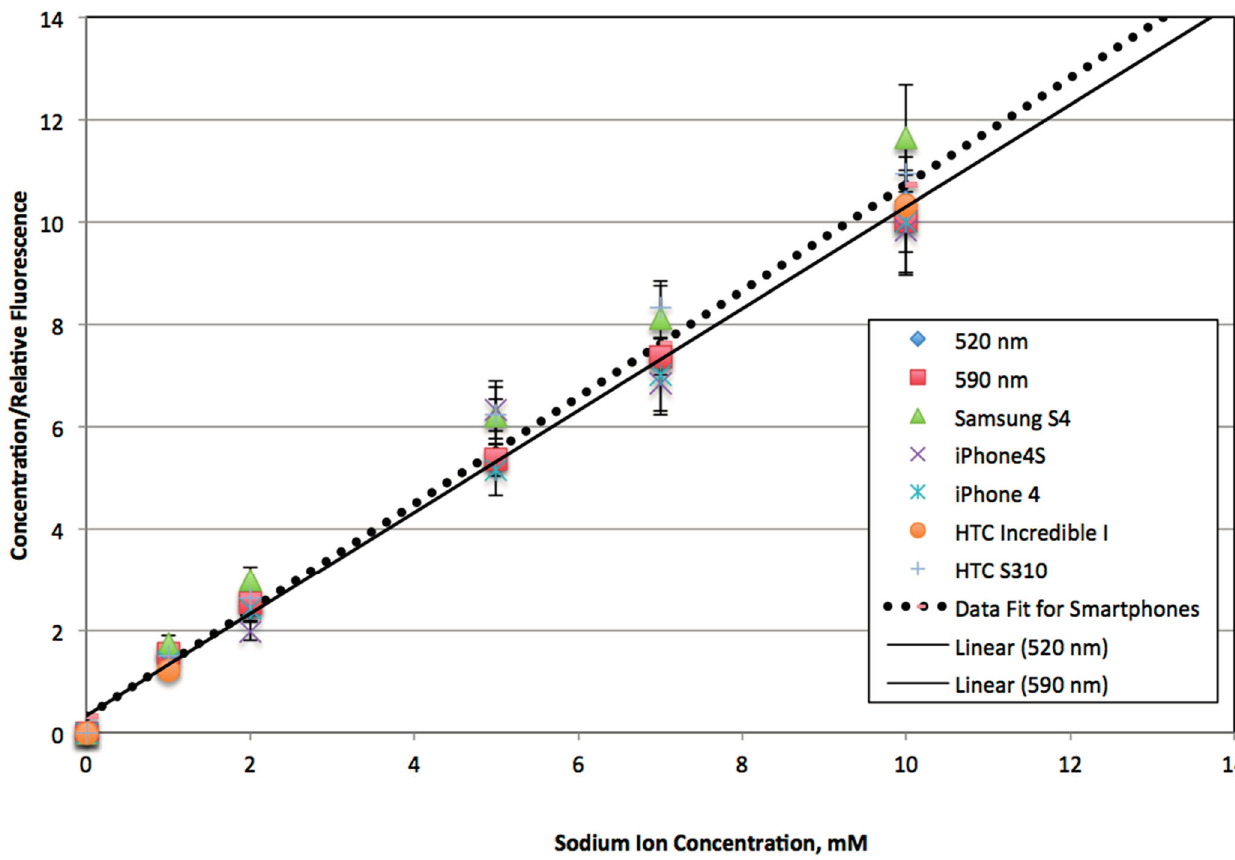
Figure 5. Another comparison series of the luminometer and smartphone fluorimeter as a function of initial sodium ion concentration along with the best-fit linear correlations are shown. All smartphones were equipped with a holographic grating, and the green channel was used to calculate fluorescence based on integrated density measurements.